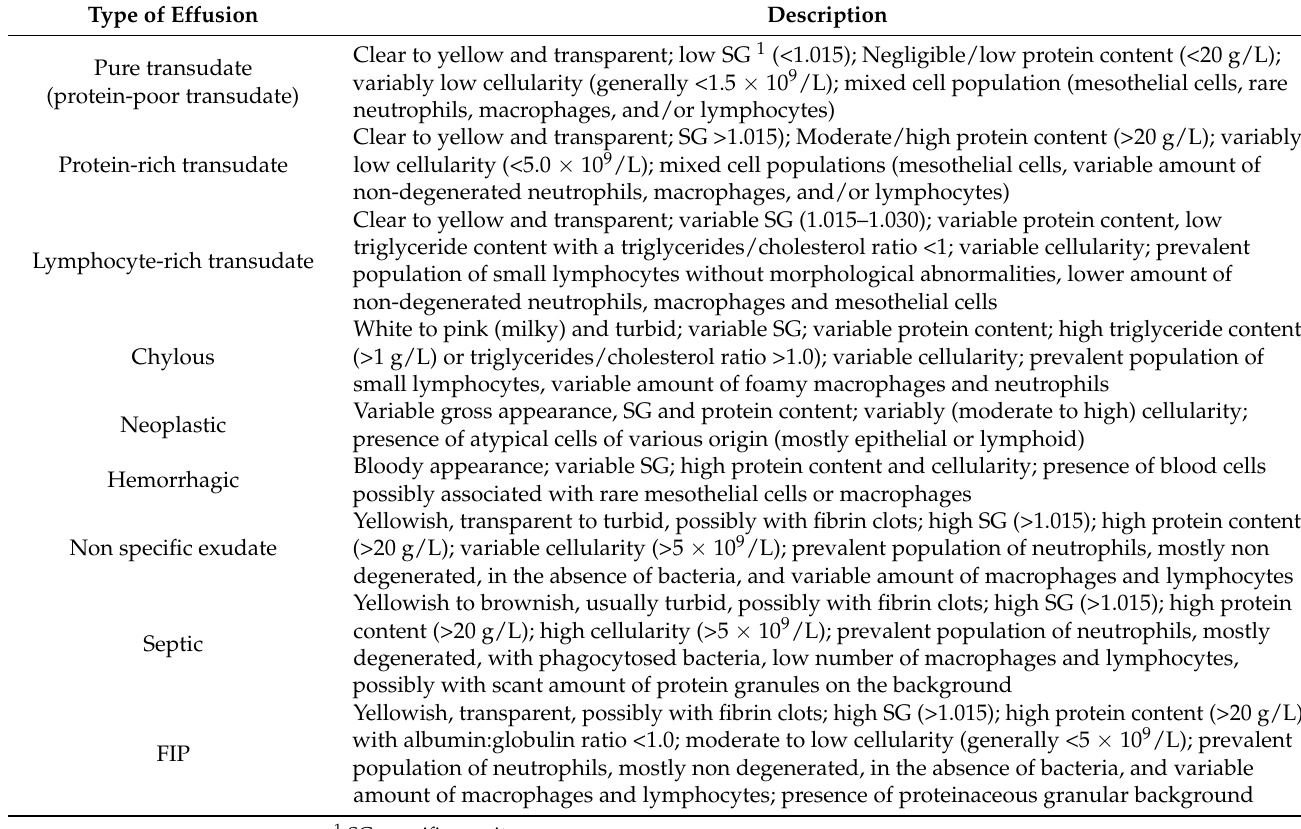
Table 1. Classification of effusion based on TNCC, chemical analyses and